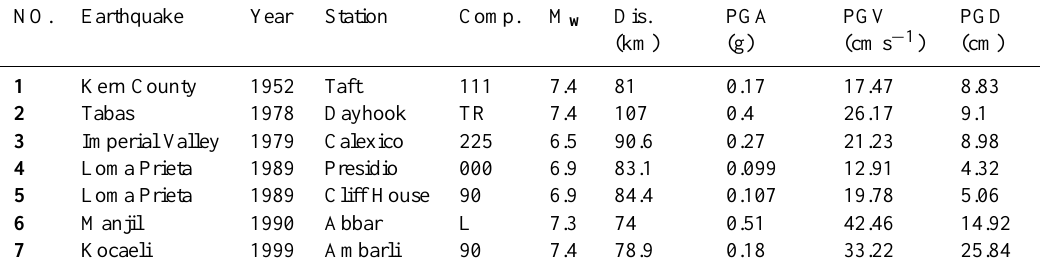
Table 4. Far-field ground motion database.